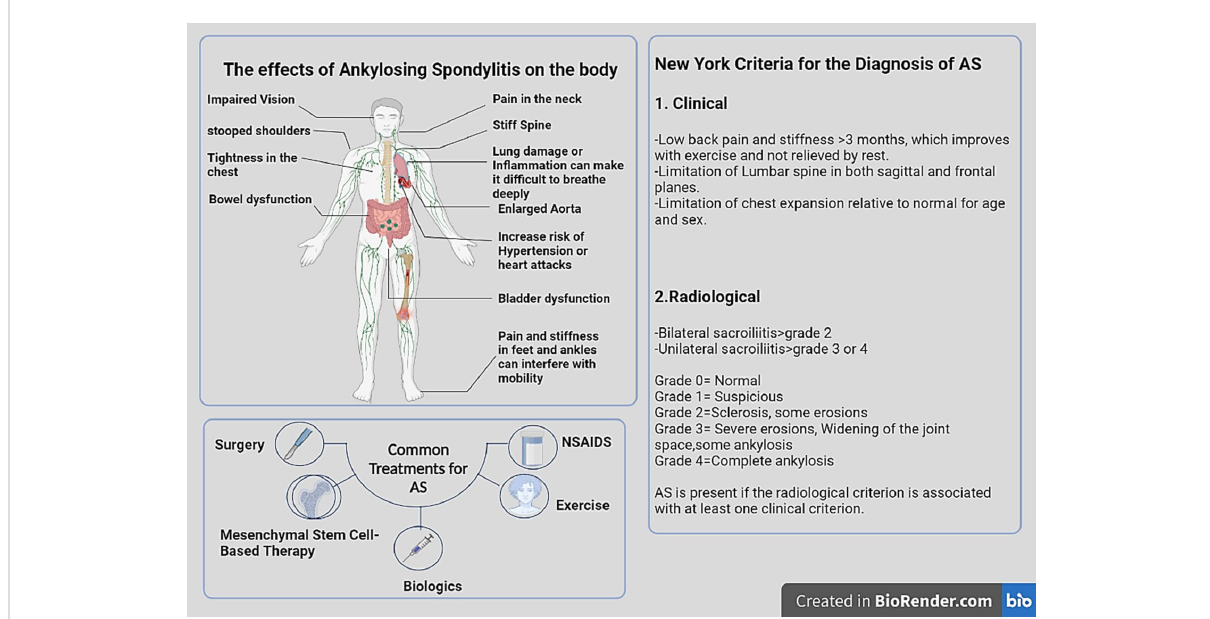
FIGURE 1 The physical manifestations of AS and a guide to diagnose and treatment. In AS, in fl ammation mostly affects axial joints, entheses, and extra- articular systems, including the uveal tract, digestive tract, mucocutaneous tissue, and heart. HLA-B27 is closely linked to spondyloarthropathies, particularly AS. In order to diagnose AS, at least one clinical indicator and one radiologic indicator are necessary. Bone scanning and magnetic resonance imaging (MRI) may help in the early detection of in fl ammation of the axial skeleton. Effective therapies for AS include local or systemic corticosteroid therapy, exercise, NSAIDs, DMARDs, methotrexate, azathioprine, anti-IL-17A monoclonal antibodies, TNF- antagonists, and MSCs therapy. Image was created with